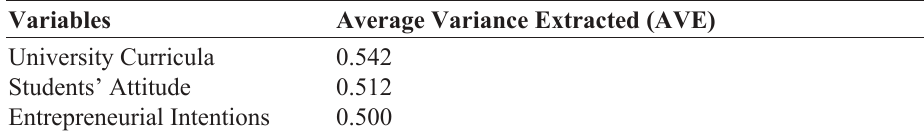
Average Variance Extracted (AVE)